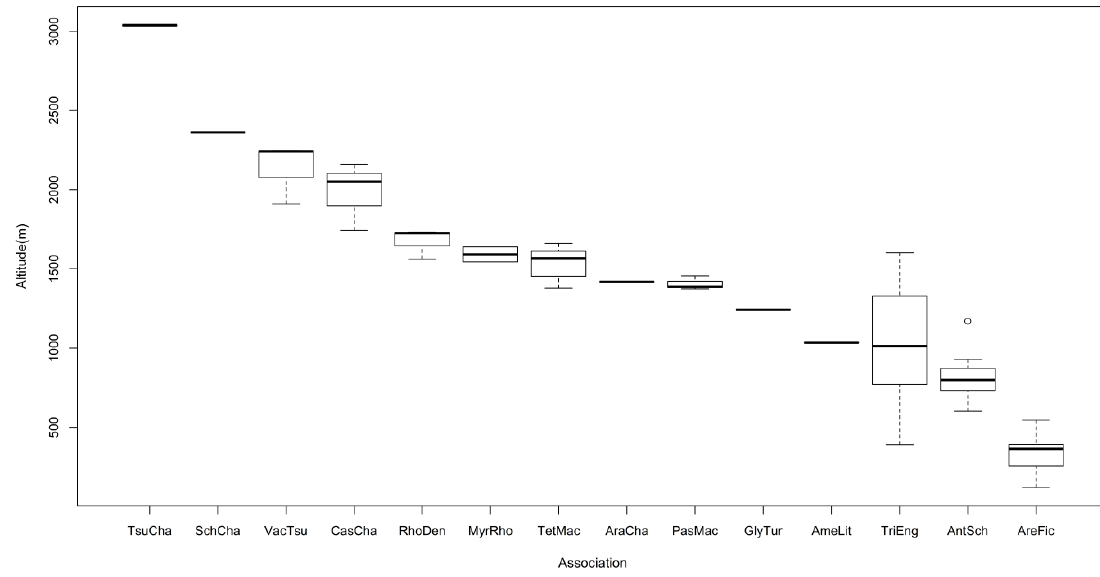
Figure 3. Distribution of associations in eastern side (TsuCha: Tsugo formosanae – Chamaecyparidetum formosanae ; SchCha: